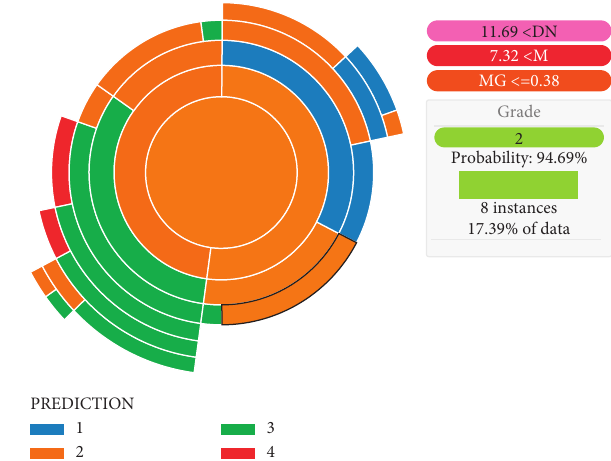
Figure 7: Prediction distribution of the decision tree model from the perspective of the sunburst